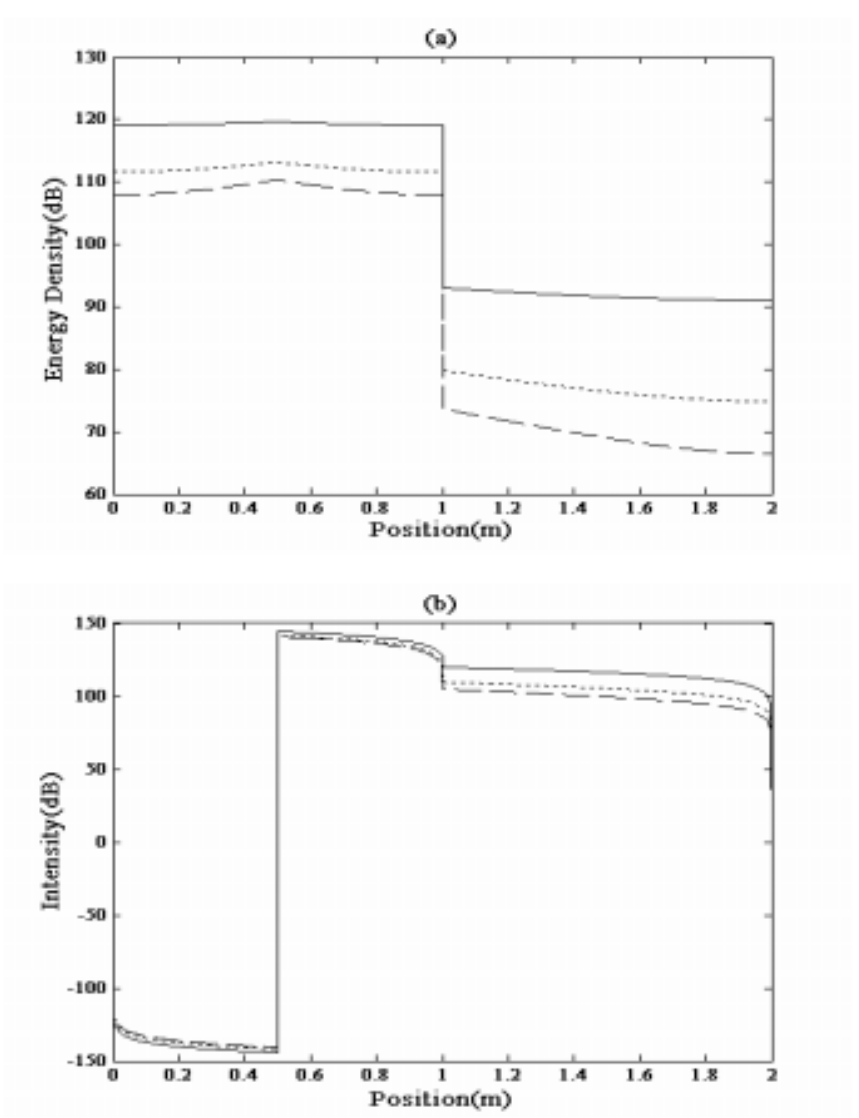
Fig. 5. Energy and intensity distributions of two-beam structure coupled with Φ = 90 ◦ when K x = K y = 10 9 N/m, K θ = 10 6 Nm/rad, C θ = 10 4 Nms/rad, C x = C y = 10 7 Ns/m and η = 0.1. (a) flexural wave energy, (b) flexural wave